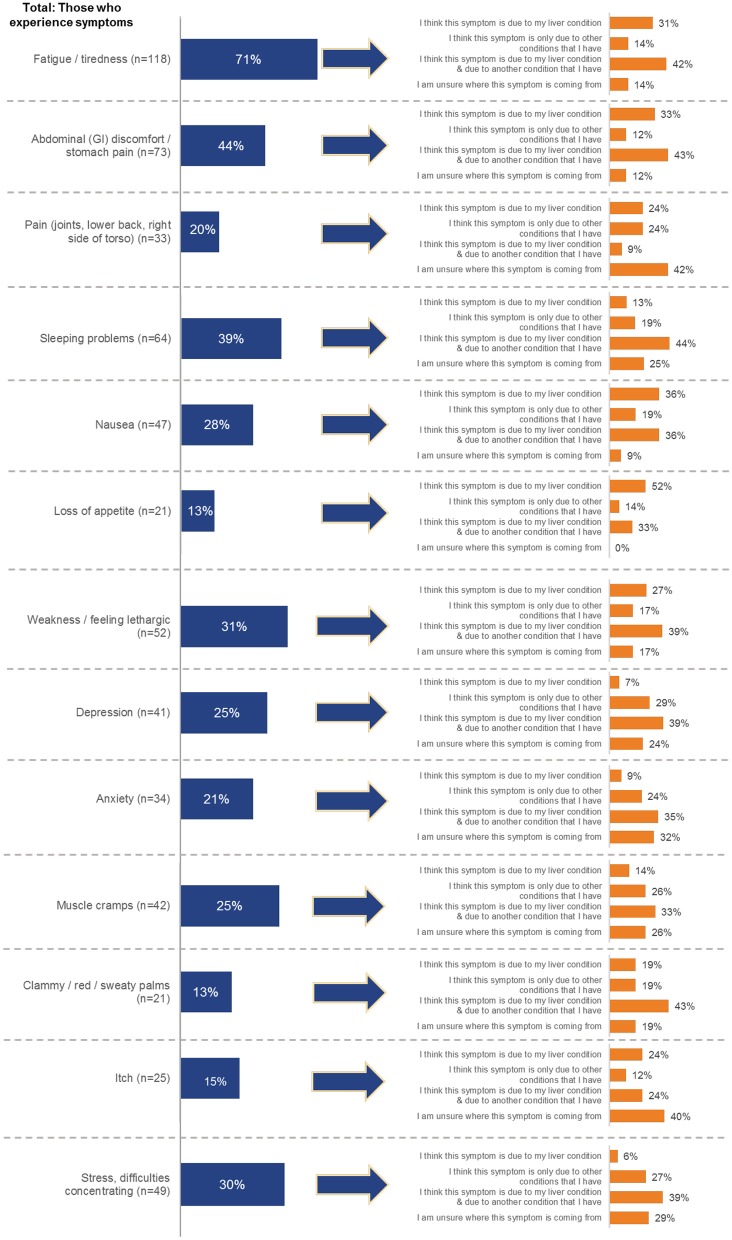
Overall summary of analysis of symptoms attributed to NASH. Patients were asked to indicate which symptoms they are experiencing, and then asked to indicate what was causing their symptoms.